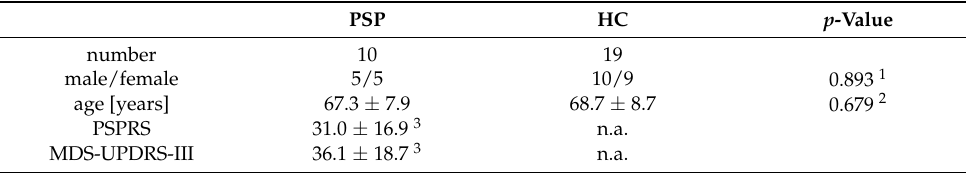
Table 1. Demographic and clinical